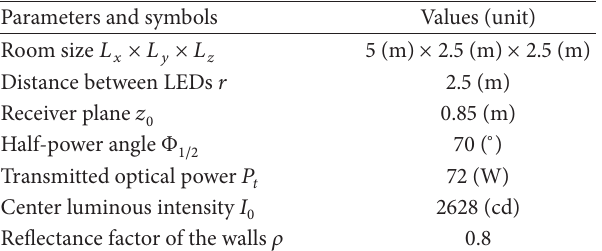
Table 1: Simulation domain